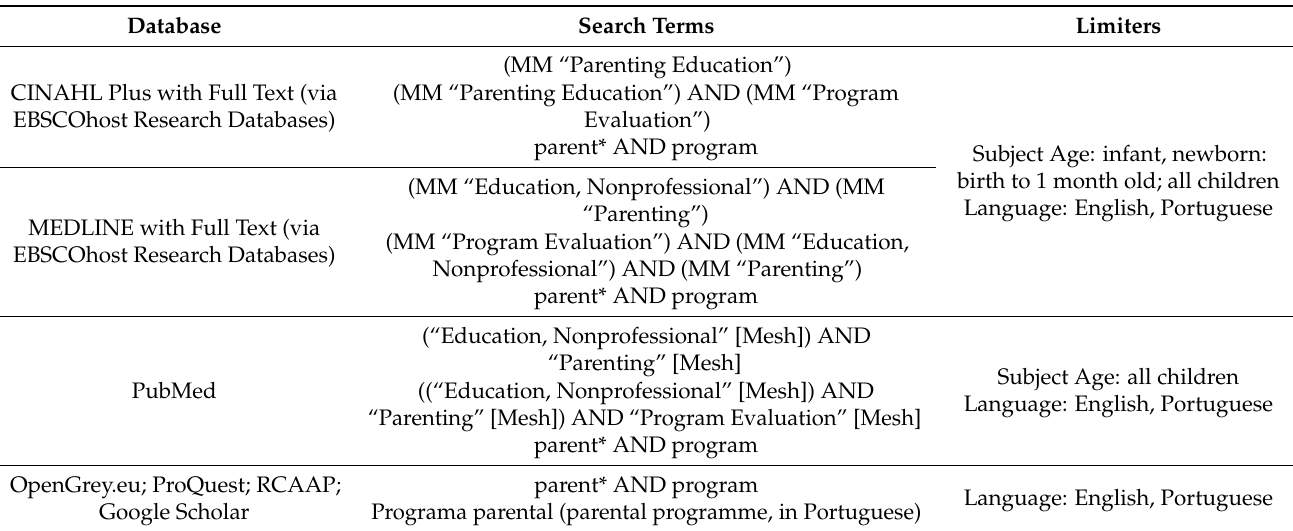
Table 1. Search terms identified in all databases